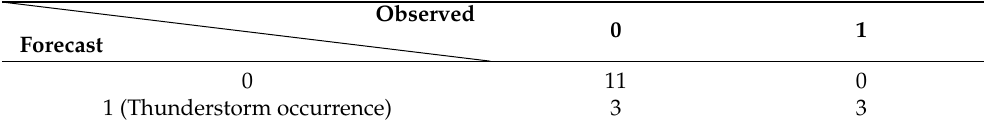
Table 2. The contingency table for the validation of the classification model in Patna. Forecast